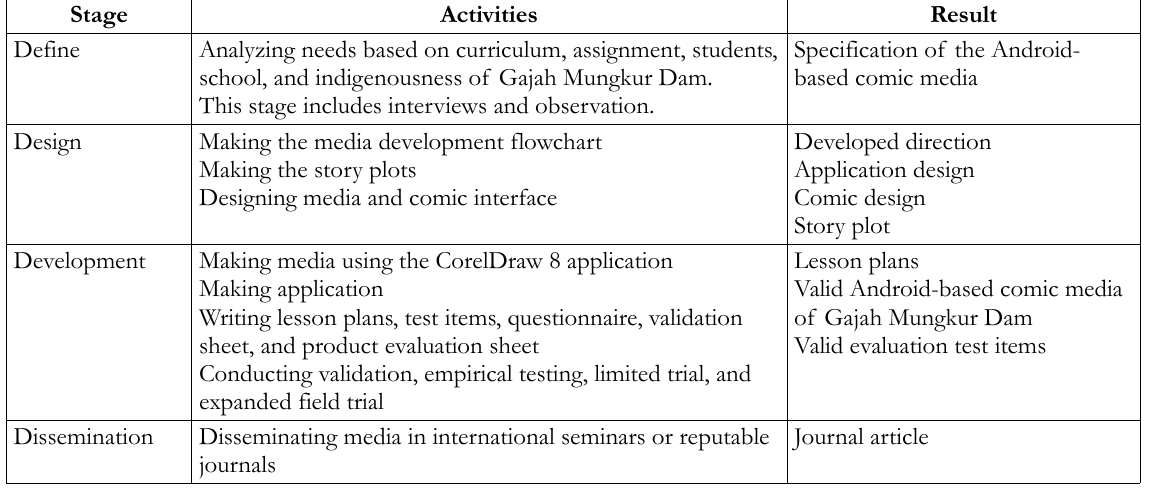
Table 1. Stages of Developmental